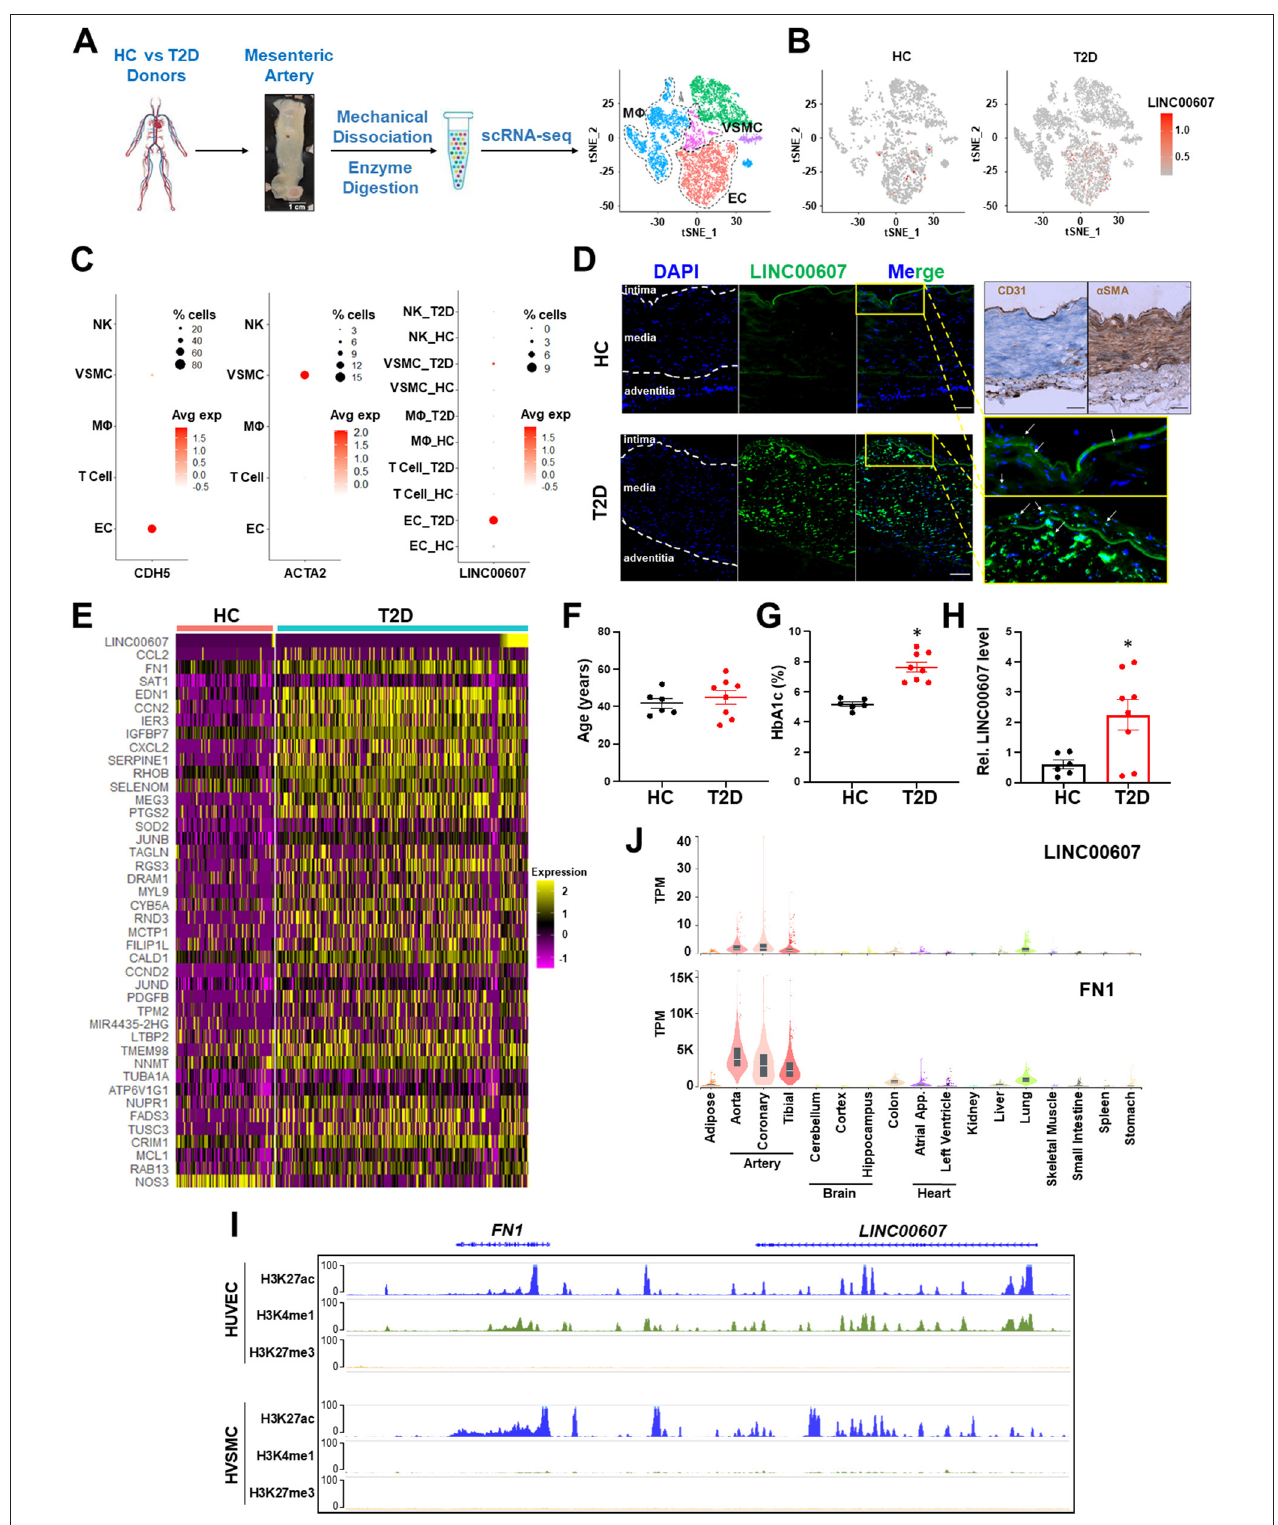
FIGURE 1 | Expression of LINC00607 in human arteries. (A) Workflow of intimal layer isolation from human mesenteric artery samples from healthy control (HC) and type 2 diabetic (T2D) donors through single cell isolation and transcriptomic profiling to identify major cell types plotted on UMAP. (B) UMAP of LINC00607 expression level in each single cell across different cell clusters/cell types in HC or T2D donors. The RNA levels are represented by log-normalized unique molecular